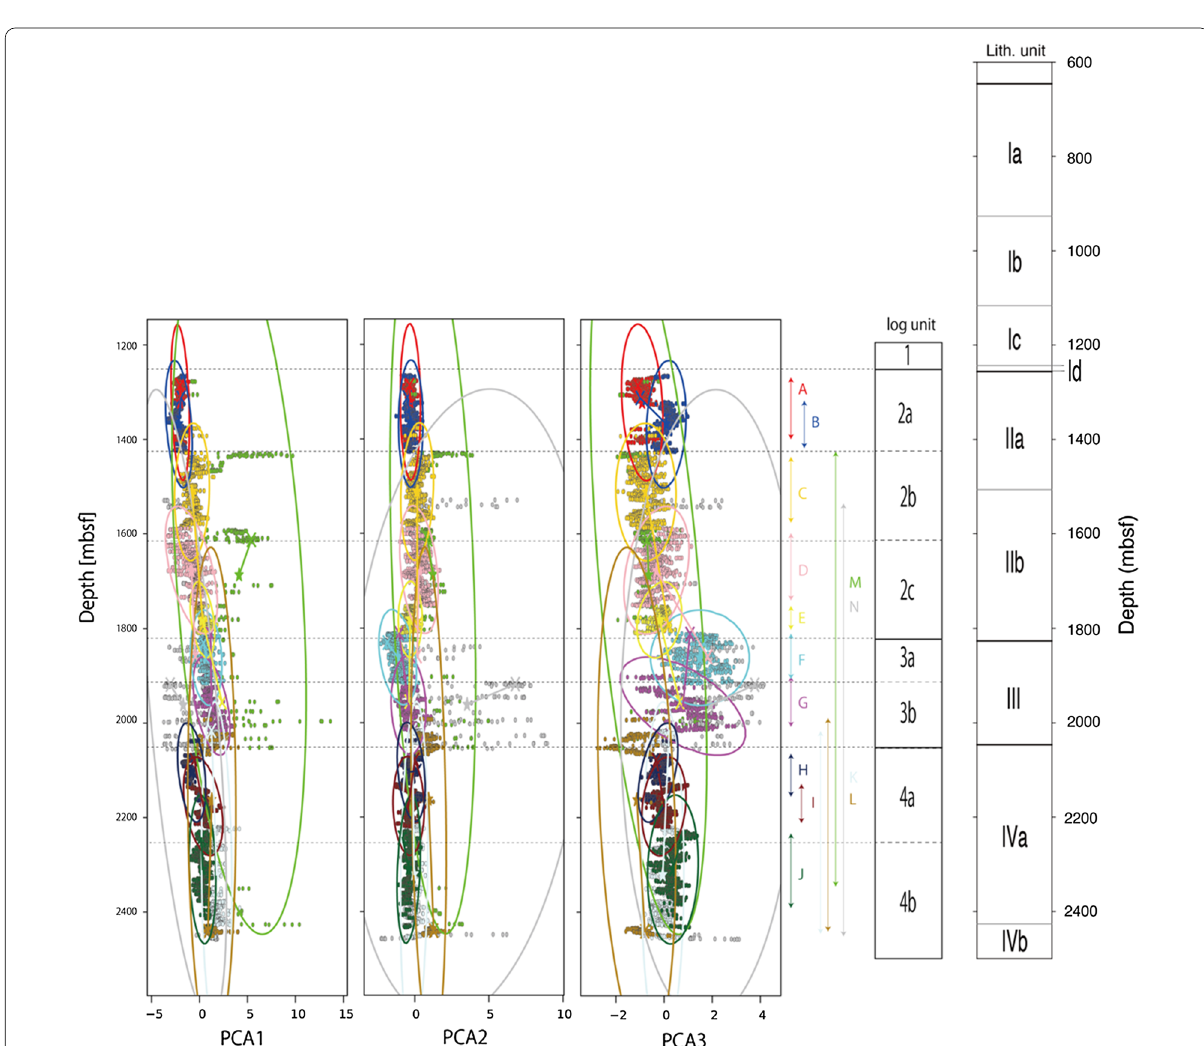
Fig. 11 Clustering results at C0020 in principal component domain and previously reported log units (Expedition 337 Scientists 2013b). Ellipses represent covariance of each